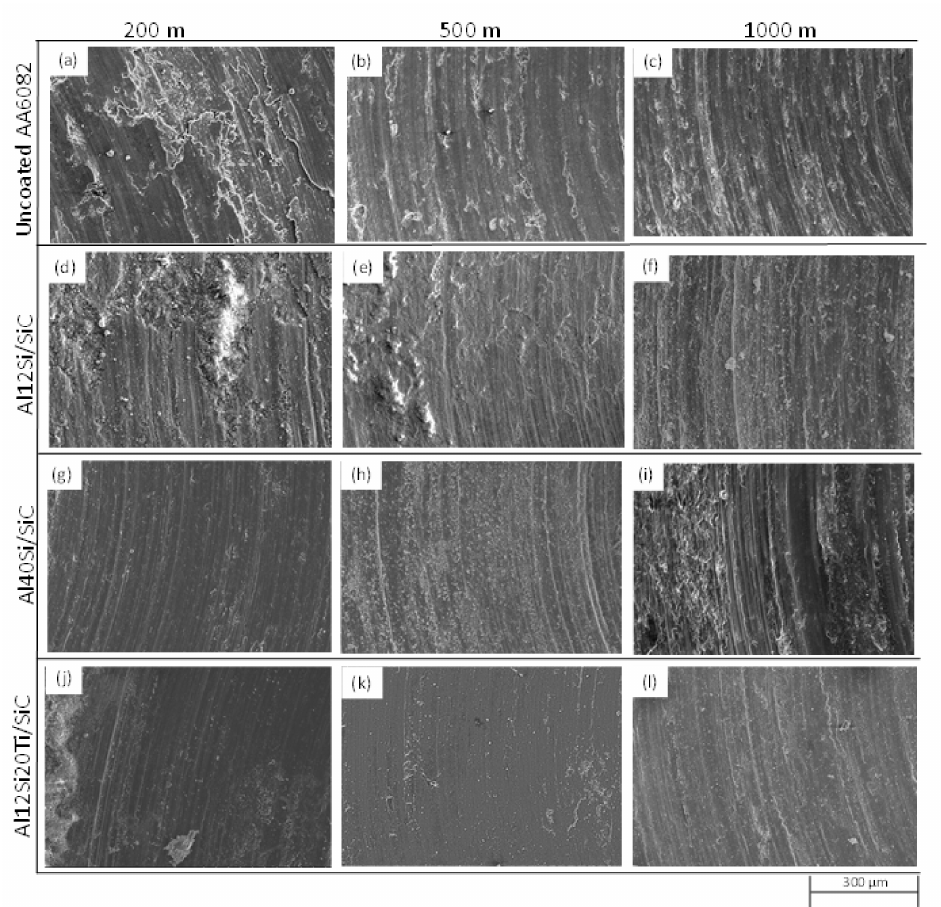
Figure 6. SEM micrographs of the worn surfaces of the uncoated AA6082 and the different coatings (Al12Si/SiC, Al40Si/SiC, and Al12Si20Ti/SiC) with the sliding distances (200 m, 500 m, and 1000 m); ( a ) uncoated AA6082 worn surface (200 m); ( b ) uncoated AA6082 worn surface (500 m); ( c ) uncoated AA6082 worn surface (1000 m); ( d ) Al12Si/SiC coating worn surface (200 m); ( e ) Al12Si/SiC coating worn surface (500 m); ( f ) Al12Si/SiC coating worn surface (1000 m); ( g ) Al40Si/SiC coating worn surface (200 m); ( h ) Al40Si/SiC coating worn surface (500 m); ( i ) Al40Si/SiC coating worn surface (1000 m); ( j ) Al12Si20Ti/SiC coating worn surface (200 m); ( k ) Al12Si20Ti/SiC coating worn surface (500 m); and ( l ) Al12Si20Ti/SiC coating worn surface (1000